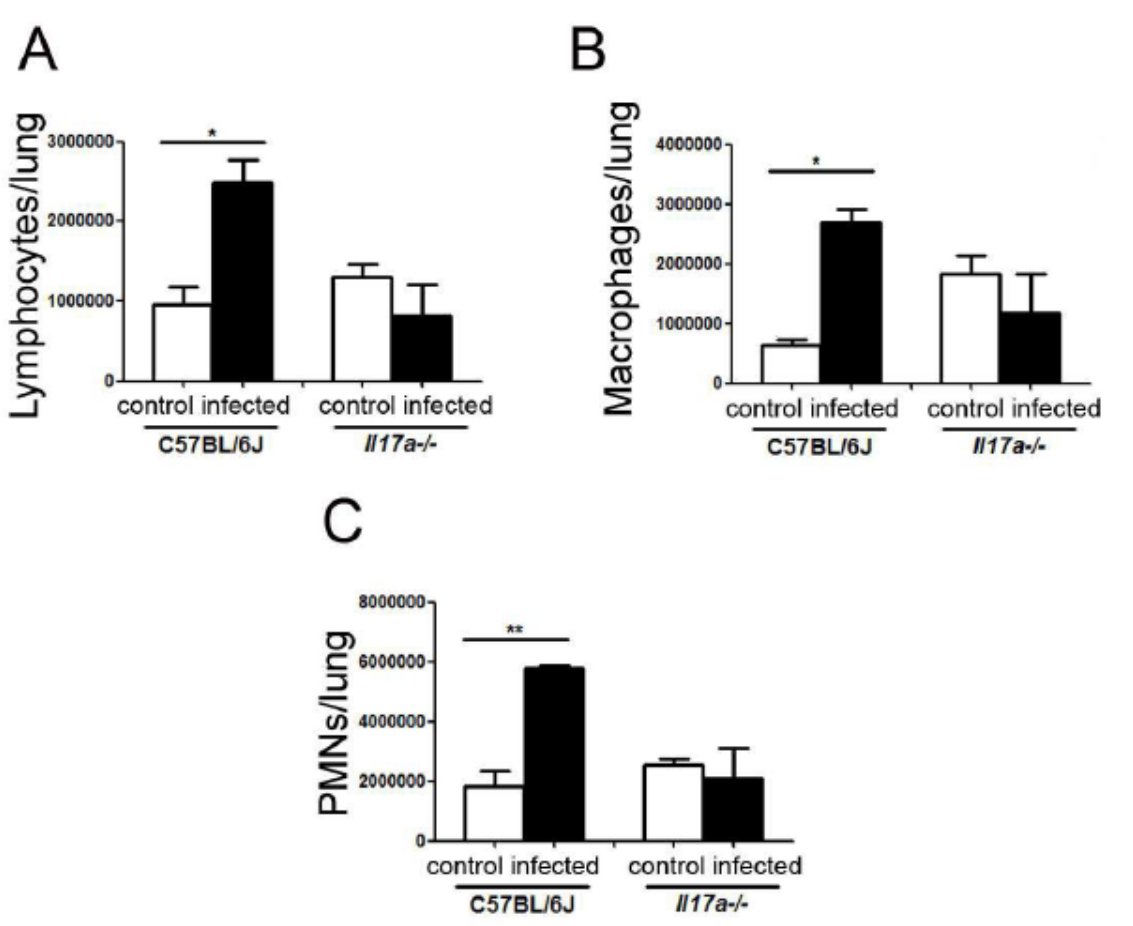
Figure 7. Recruitment of immune cells in lungs of C57BL/6J and Il17a − / − mice. Animals were infected as described in M&M, and after 9 days, lungs ( A – C ) were removed. Organs were homogenized as described in M&M, and total number of lymphocytes ( A ), macrophages ( B ), and PMNs ( C ) was quantified. Asterisks indicate significant differences.